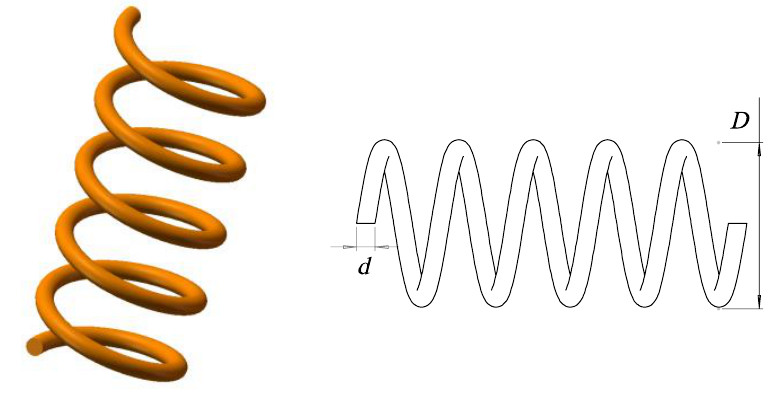
Figure 11. Tension spring design problem.